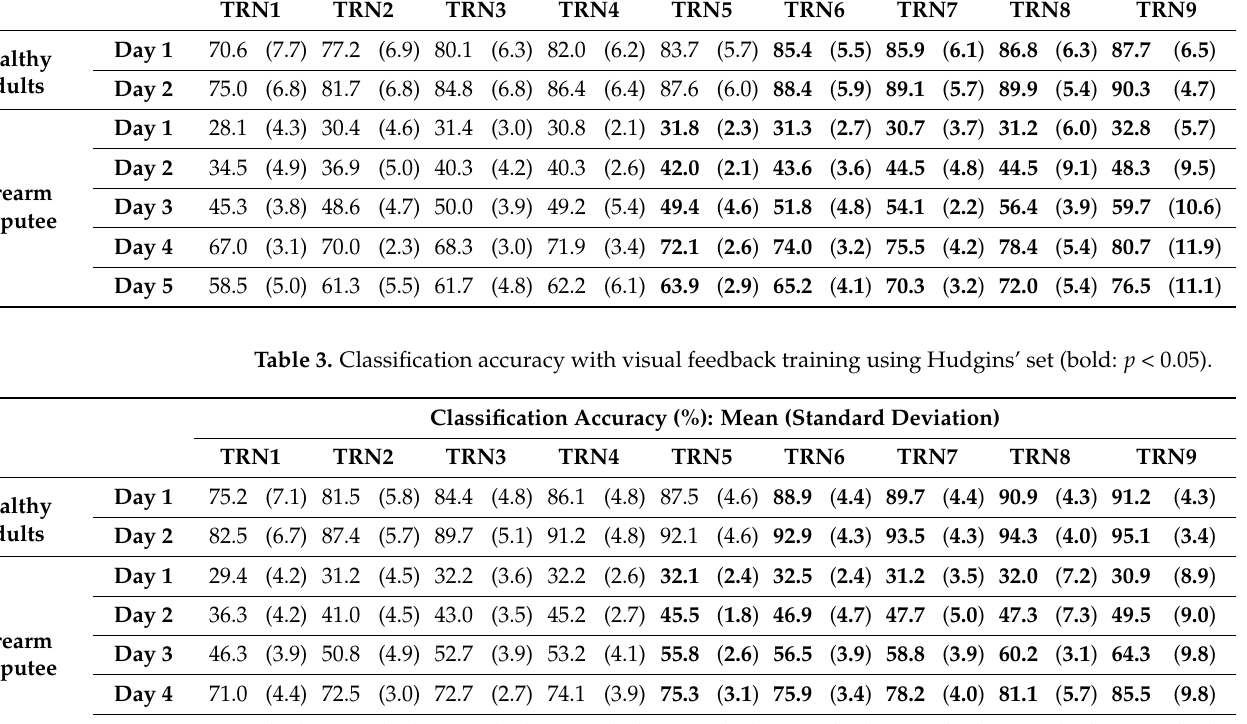
Table 2. Classification accuracy with visual feedback training using MAV only (bold: p < 0.05). Classification Accuracy (%): Mean (Standard Deviation)